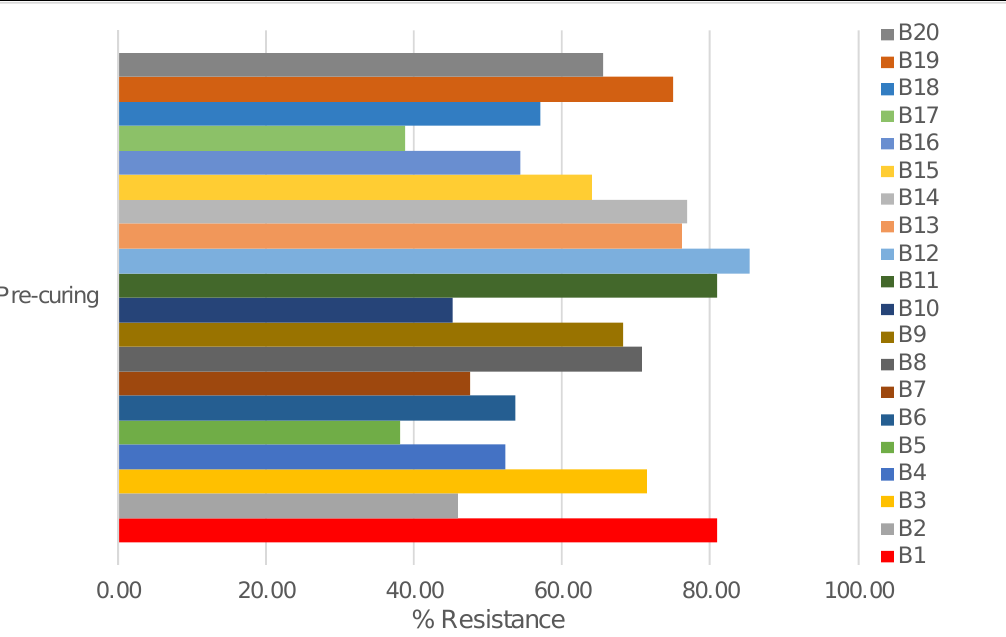
Figure 3. Level of AR (%) in ( A ). strawberry; ( B ). gooseberry. The bars represent the % of bacteria that showed resistance to different number of antibiotics tested. Legend: SFS-strawberries from a local farm grower; SFM: strawberries from low-cost market; PFS: gooseberries from a local farm grower; PFM: gooseberries from low-cost market; S- susceptible; R-resistant.